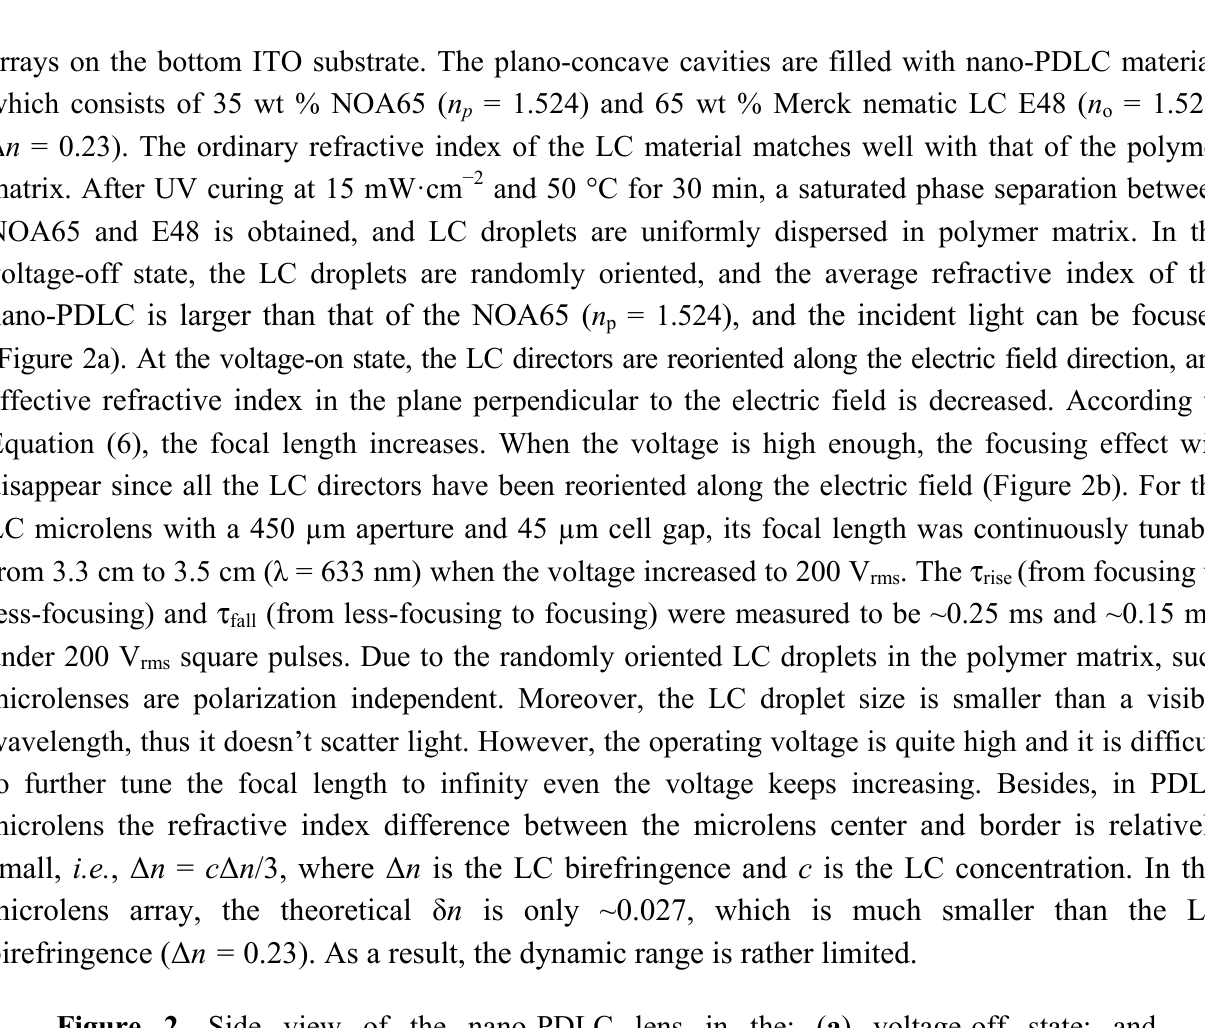
Figure 2. Side view of the nano-PDLC lens in the: ( a ) voltage-off state; and ( b ) voltage-on